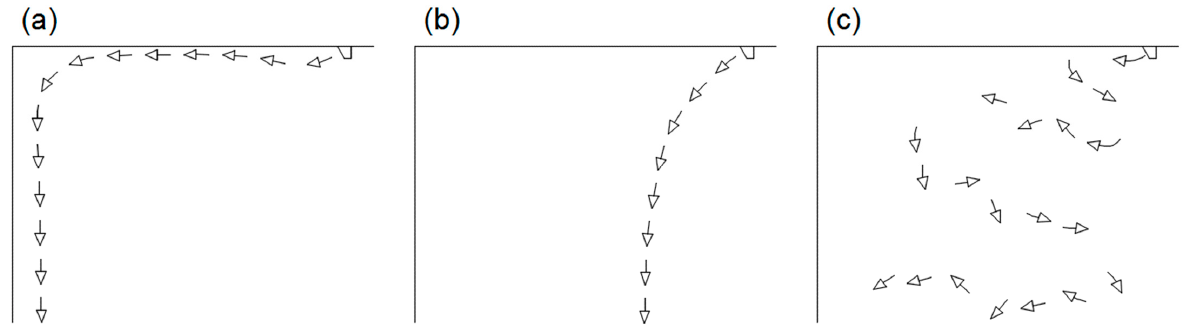
Figure 2. Analyzed variants of air flow: ( a ) steady flow with Coanda effect, ( b ) steady flow with a free jet, ( c ) unsteady flow in the region of CEH.